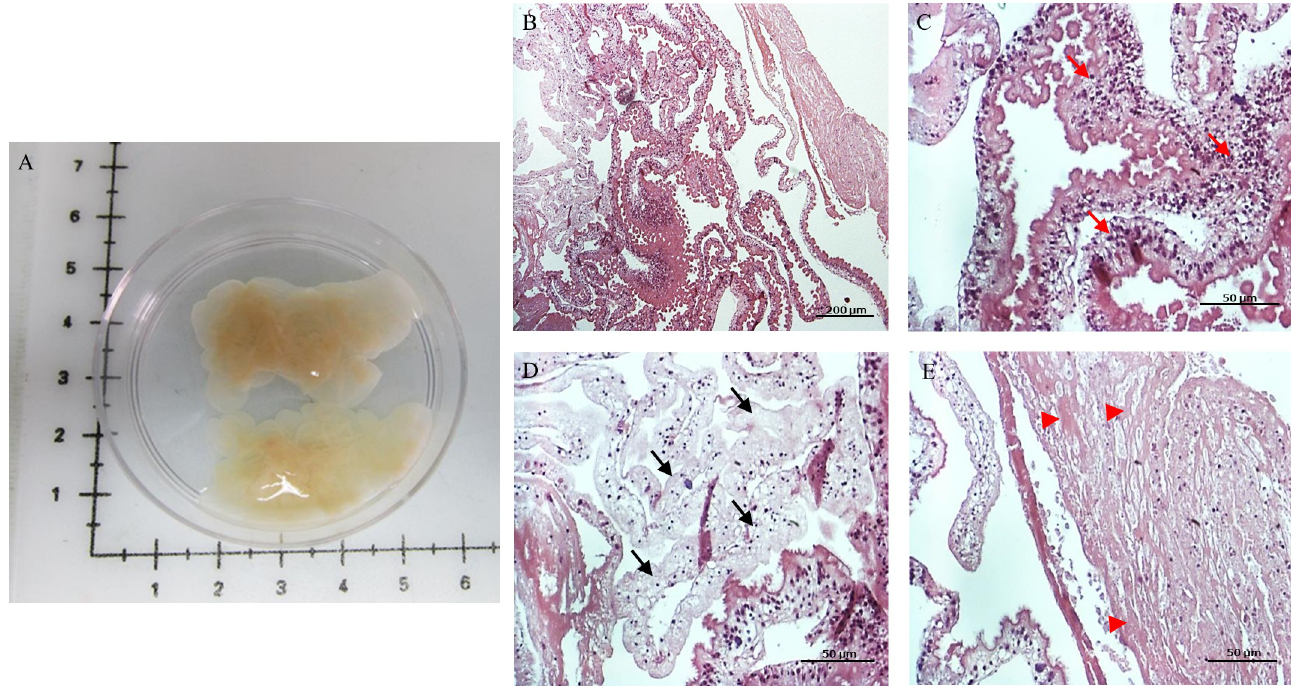
Fig 1. Racemose larvae sample. Macroscopic view of representative sample (A) and HE stain of the sample (B). Three selected regions with different histological characteristics; region with intact or viable tissue (C), the tegument has normal morphology with microtriches on the surface (red arrows are pointing to hypertrophic/integrity regions); region with tissue degeneration (black arrows) (D); region with a high degree of necrosis (E) characterized by the absence of nuclei (arrow head).